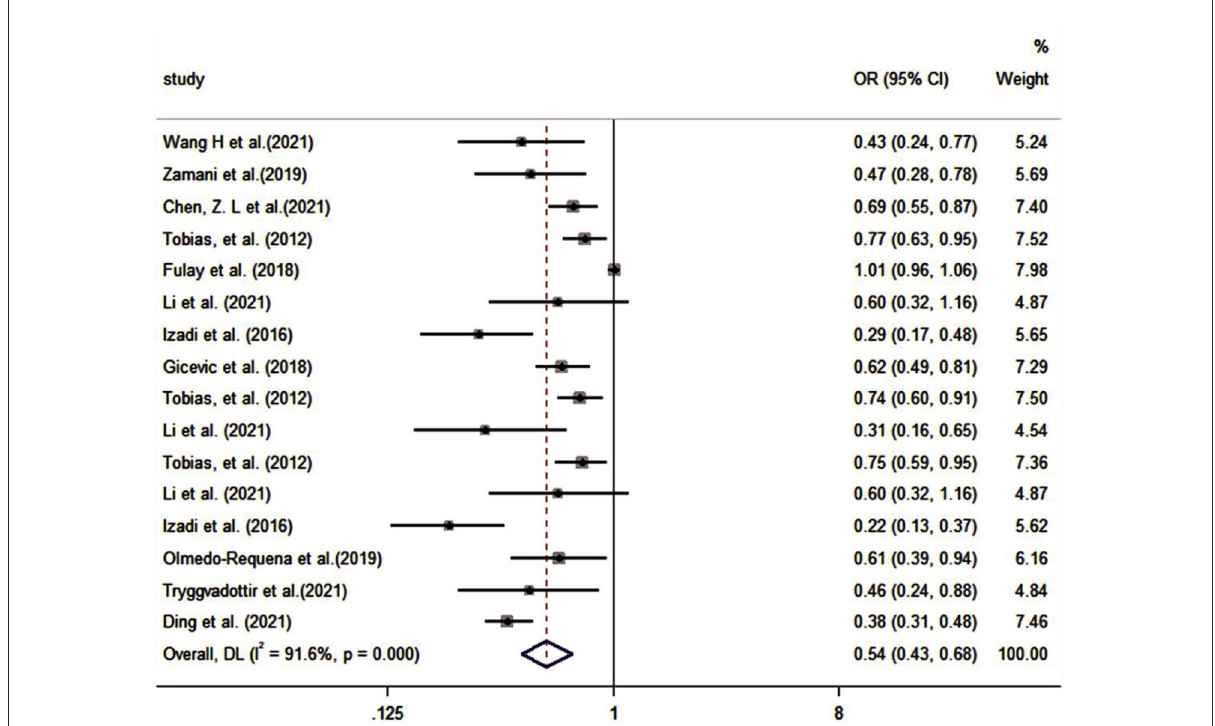
FIGURE3 Forest plot for the association of the Group A with GDM (weights are from random-effects model).